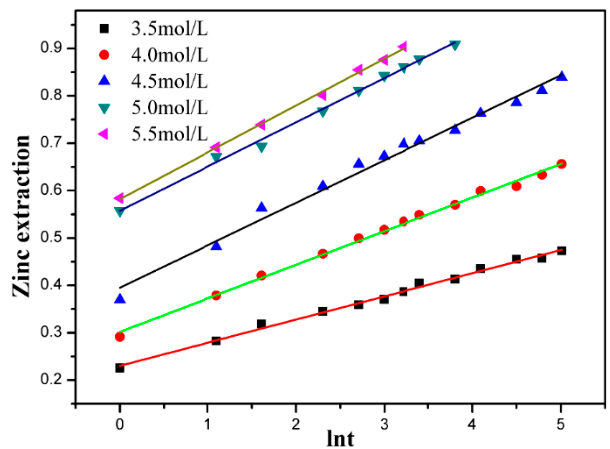
Figure 9. Plot of zinc extraction versus ln t for different NH 4 Cl concentrations.